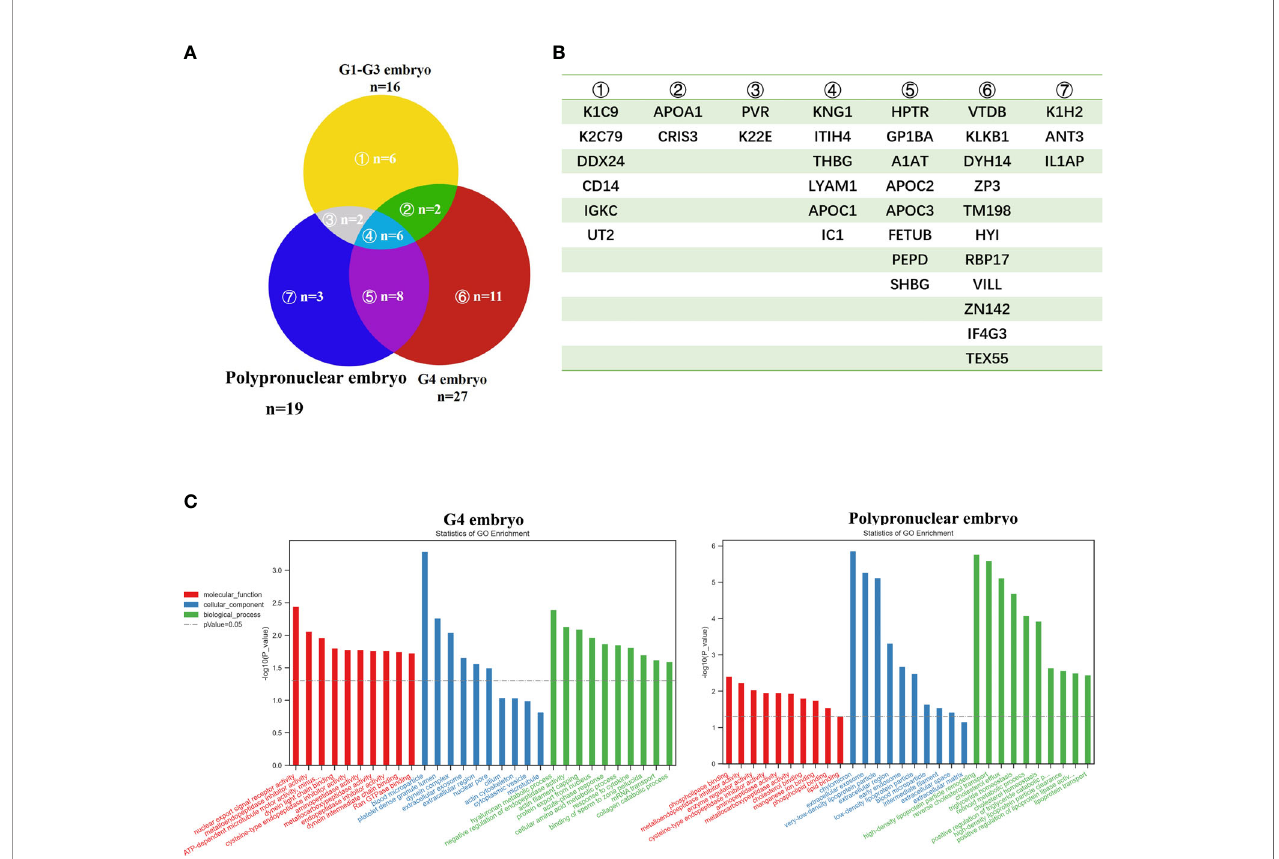
FIGURE 2 | The secretome analysis of embryos with different grades. (A, B) Venn graph of the secretome of embryos with different grades, and the corresponding protein names of each part. (C) GO analysis of the secretome of embryos with different